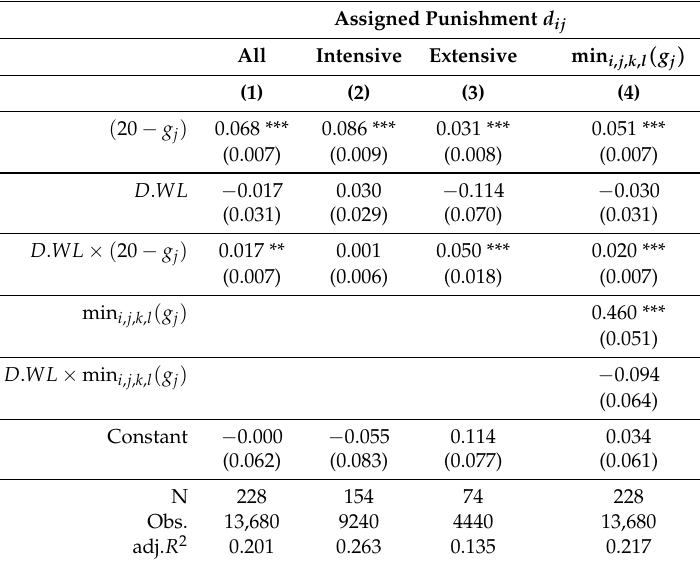
Table 3. Punishment demand across